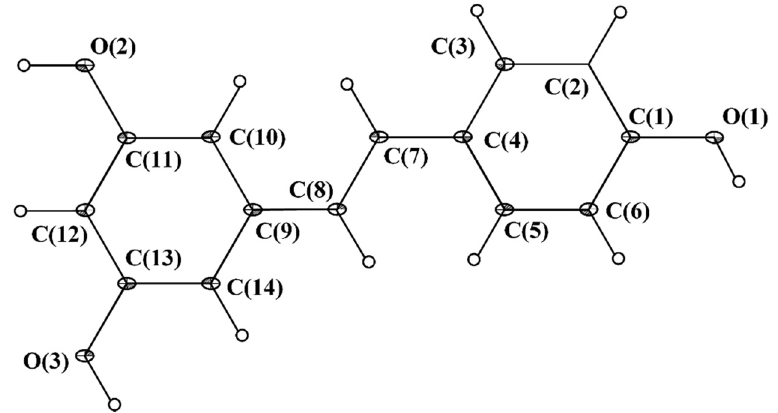
Figure 6: The structure of resveratrol [ 33 ]